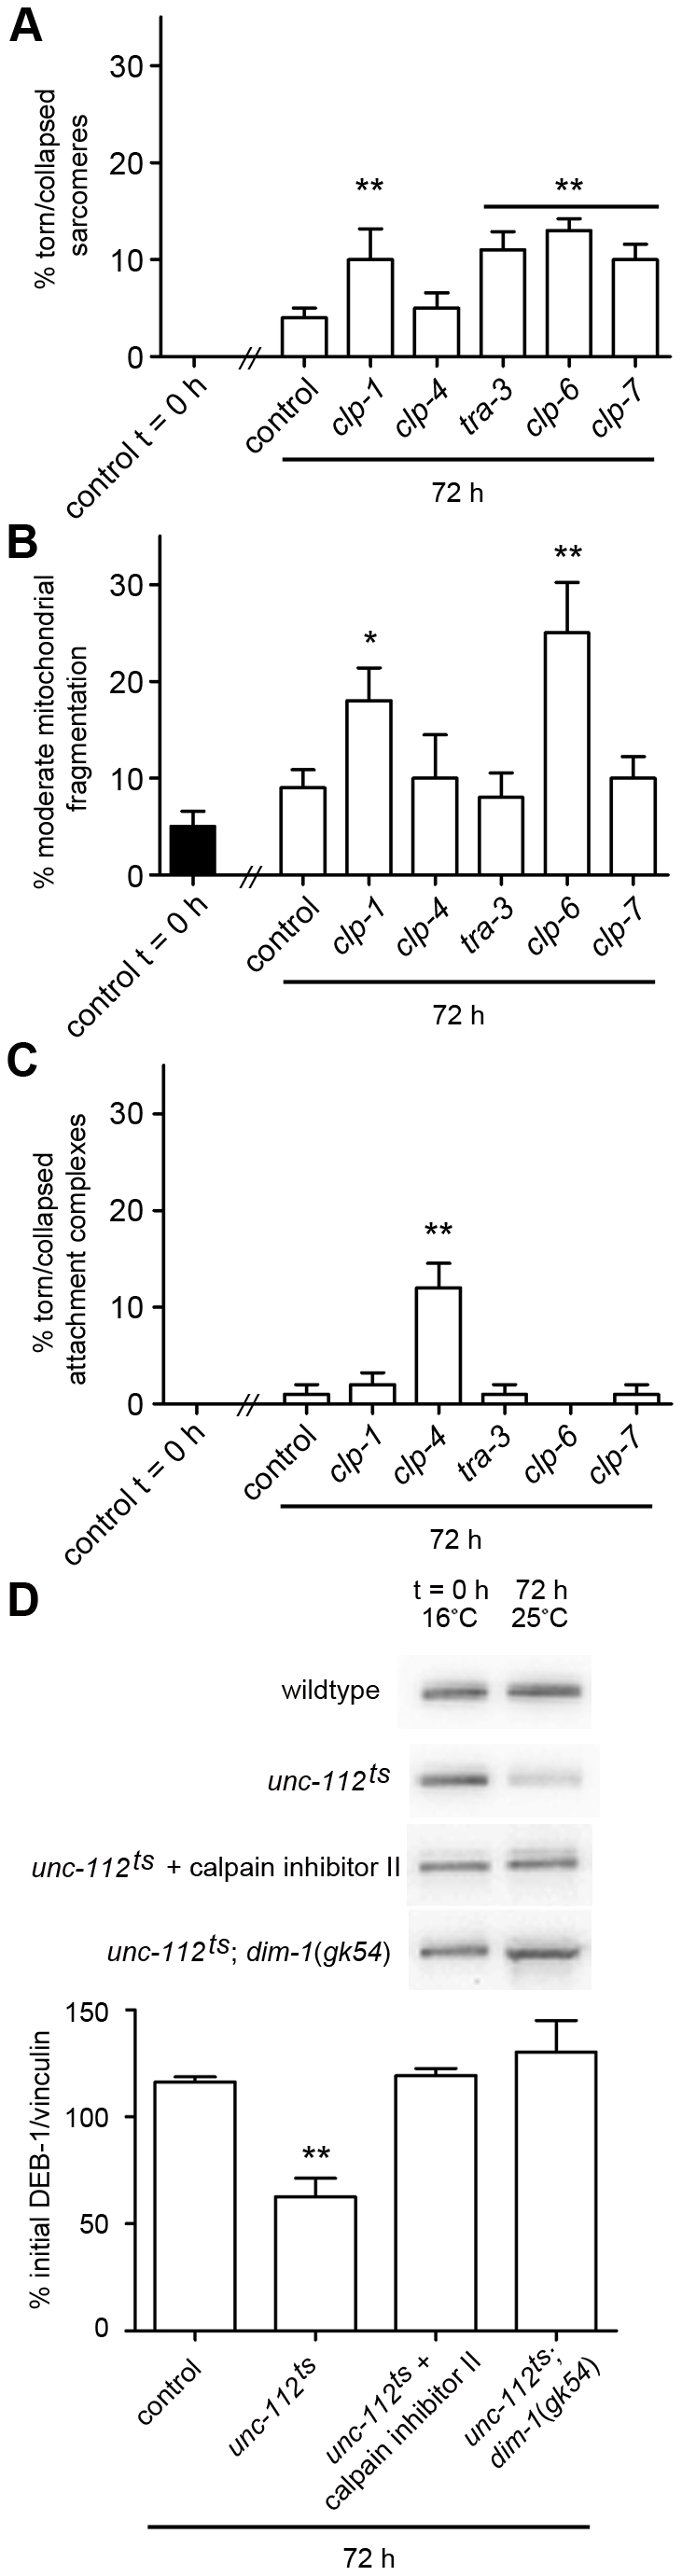
Calpains are important for maintenance of adult C. elegans muscle.A) Animals expressing a full length translational fusion of gfp to myo-3 (myosin heavy chain A) were age synchronised at L1 stage and grown to young adulthood at 16°C (t = 0 h). Adult animals were then transferred to NGM RNAi plates [87] seeded with bacteria expressing dsRNA against genes indicated for a further 72 h to mid-adulthood. 20 random animals were picked and scored for identical defects in sarcomere structure in at least two muscles within the animal and this was repeated for 5 independent RNAi treatments (n = 100 animals per condition/time point). Displayed is the percentage of animals where torn or collapsed arrays of sarcomeres were observed (average ± SEM). Example images for each treatment can be found in Figure S5. **Significant difference from control (t = 72 h, (P<0.001)). B) Animals expressing GFP labelled mitochondria and nuclei were grown, treated and analysed as in A with the exception that mitochondrial structure was scored. Displayed is the percentage of animals where moderate fragmentation of the mitochondrial network was observed (average ± SEM). Example images for each treatment can be found in Figure S5. *, **Significant difference from control (t = 72 h, (P<0.01, P<0.001)). C) Animals expressing GFP labelled attachment complexes (UNC-95::GFP) were grown, treated and analysed as in A with the exception that attachment complex structure was scored. Displayed is the percentage of animals where torn or collapsed arrays of sarcomeres were observed (average ± SEM). Example images for each treatment can be found in Figure S5. **Significant difference from control (t = 72 h, (P<0.001)). D) Wild-type, unc-112ts, and unc-112ts; dim-1(gk54) were age synchronised at L1 stage and grown to young adulthood at 16°C (t = 0 h). Adult animals were then transferred to 25°C and grown for a further 72 h to mid-adulthood. Some unc-112ts animals were also placed on calpain inhibitor II drug plates (5 µg/ml) at t = 0 h and cultured on drug plates for a further 72 h. 30 animals were picked for western blot analysis of DEB-1 levels at t = 0 h, and at 72 h. All experiments were performed at least three times. Displayed are representative western blots for each condition and a graph of the initial DEB-1 remaining at 72 h (average ± SEM for three independent experiments). **Significant difference from all other conditions (P<0.001). All significance values are from two way repeated measures ANOVA.